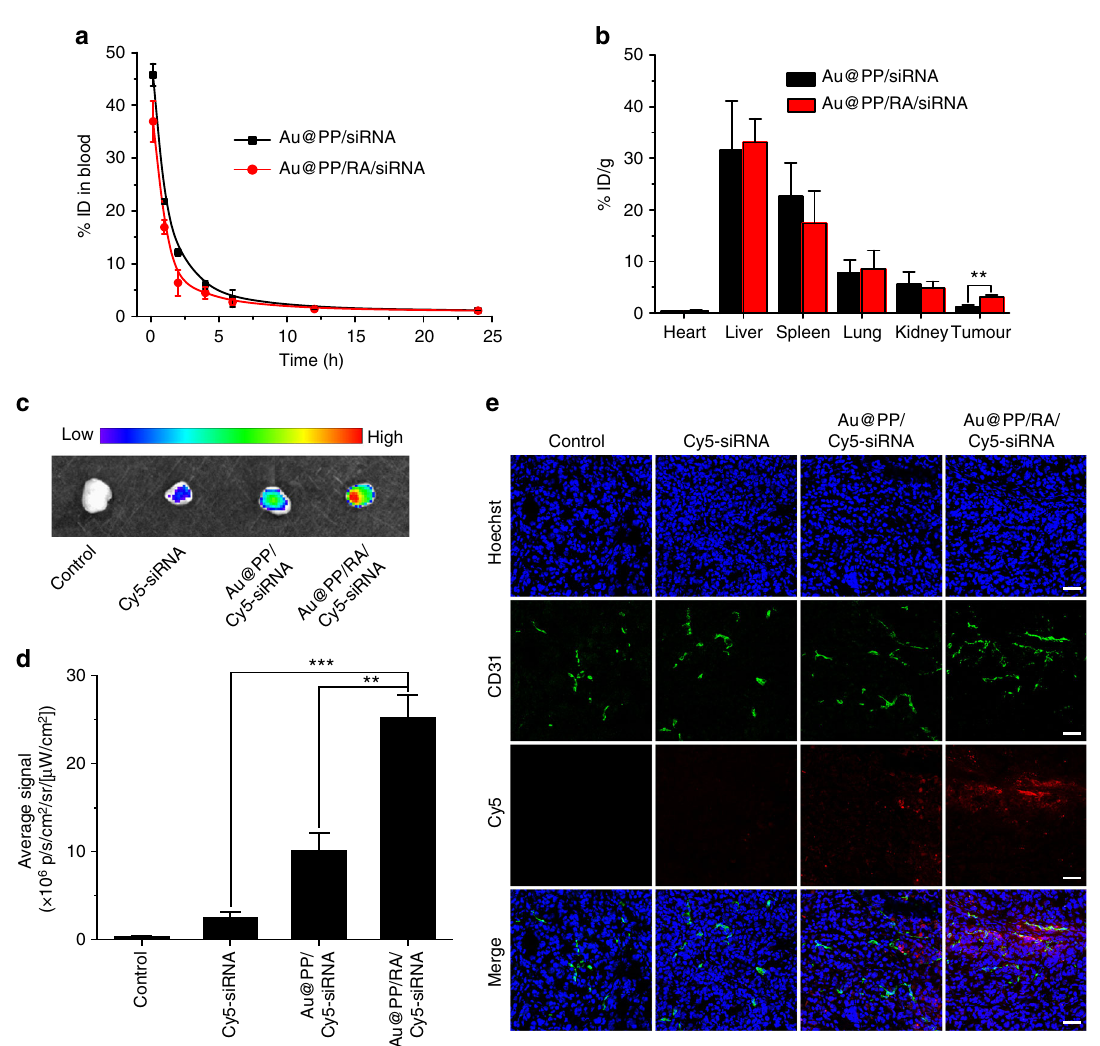
Fig. 6 Pharmacokinetics and bio-distribution of Au@PP/RA/siRNA in vivo. a Pharmacokinetic curves of Au@PP/siRNA and Au@PP/RA/siRNA as analysed by the Au content in the blood using inductively coupled plasma mass spectrometry (ICP-MS), shown as the percentage of the injected dose (% ID). b The bio-distribution of Au@PP/siRNA and Au@PP/RA/siRNA as analysed by the Au content using ICP-MS at 24 h post-injection, expressed as the percentage of the injected dose per gram of tissue (% ID/g). c Ex vivo fl uorescence images of representative tumours at 24 h post-injection of Cy5-siRNA, Au@PP/ Cy5-siRNA and Au@PP/RA/Cy5-siRNA. d Quantitative analysis of the average fl uorescence signal intensity in the tumours. e Distribution of Cy5-siRNA, Au@PP/Cy5-siRNA and Au@PP/RA/Cy5-siRNA in tumours at 24 h post-injection. Blood vessels were stained with CD31 (green) and nuclei were stained with Hoechst 33342 (blue). Scale bars, 50 μ m. The data are shown as the mean ± s.d. ( n = 3). ** p < 0.01, *** p < 0.001 (Student ’ s t